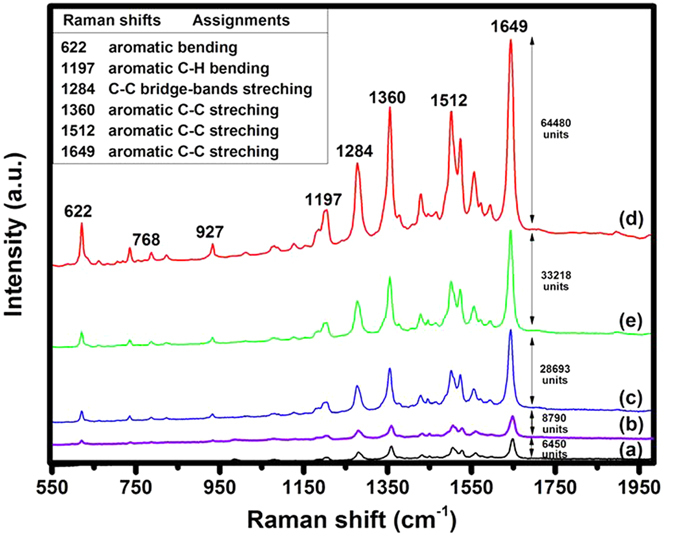
Raman spectra of 10−6 M RhB on different substrates, first on precursor Ag sponge (a) and then on the different resulting networks of (b) Ag0.918Au0.045Pd0.037, (c) Ag0.90Au0.078Pd0.022, (d) Ag0.891Au0.091Pd0.018, and (e) Ag0.889Au0.094Pd0.017.